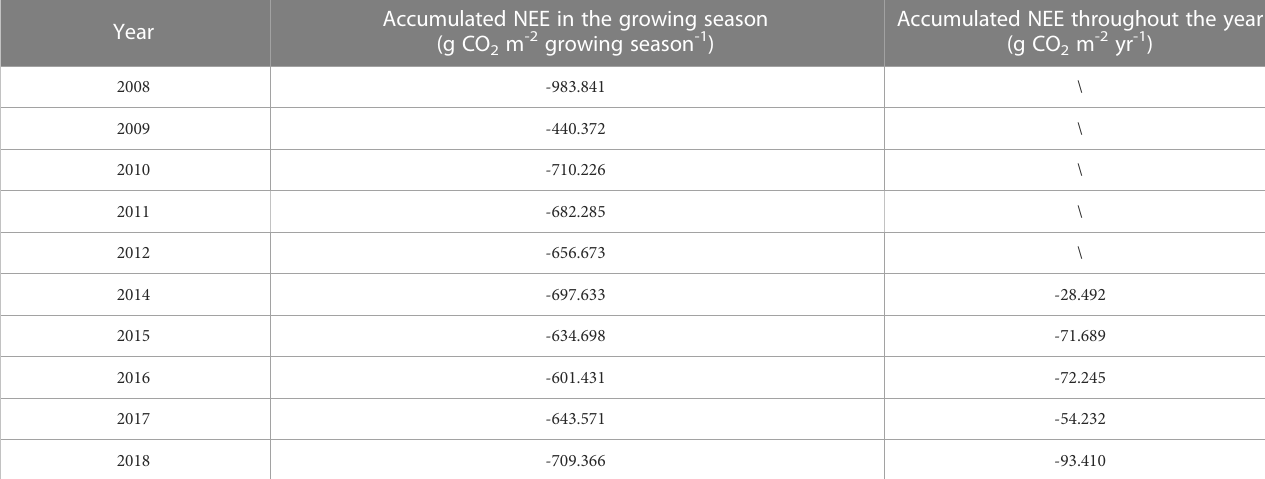
TABLE 3 Interannual variation in cumulative NEE (net ecosystem CO 2 exchange) during the growing season and throughout the